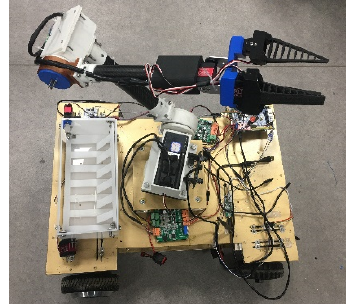
Figure 8. Prototype of the picking robot.